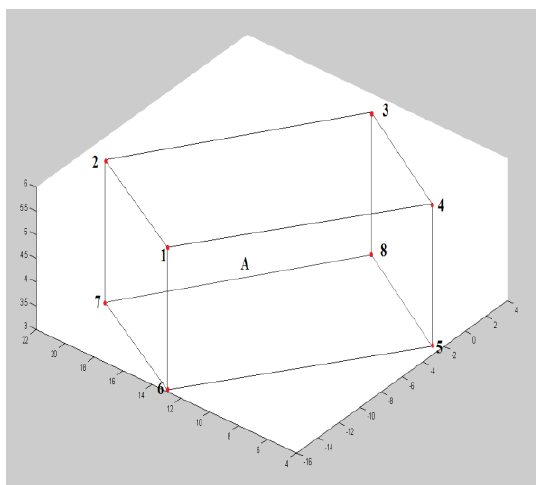
Figure 2. A room block where vertices are represented as red points.